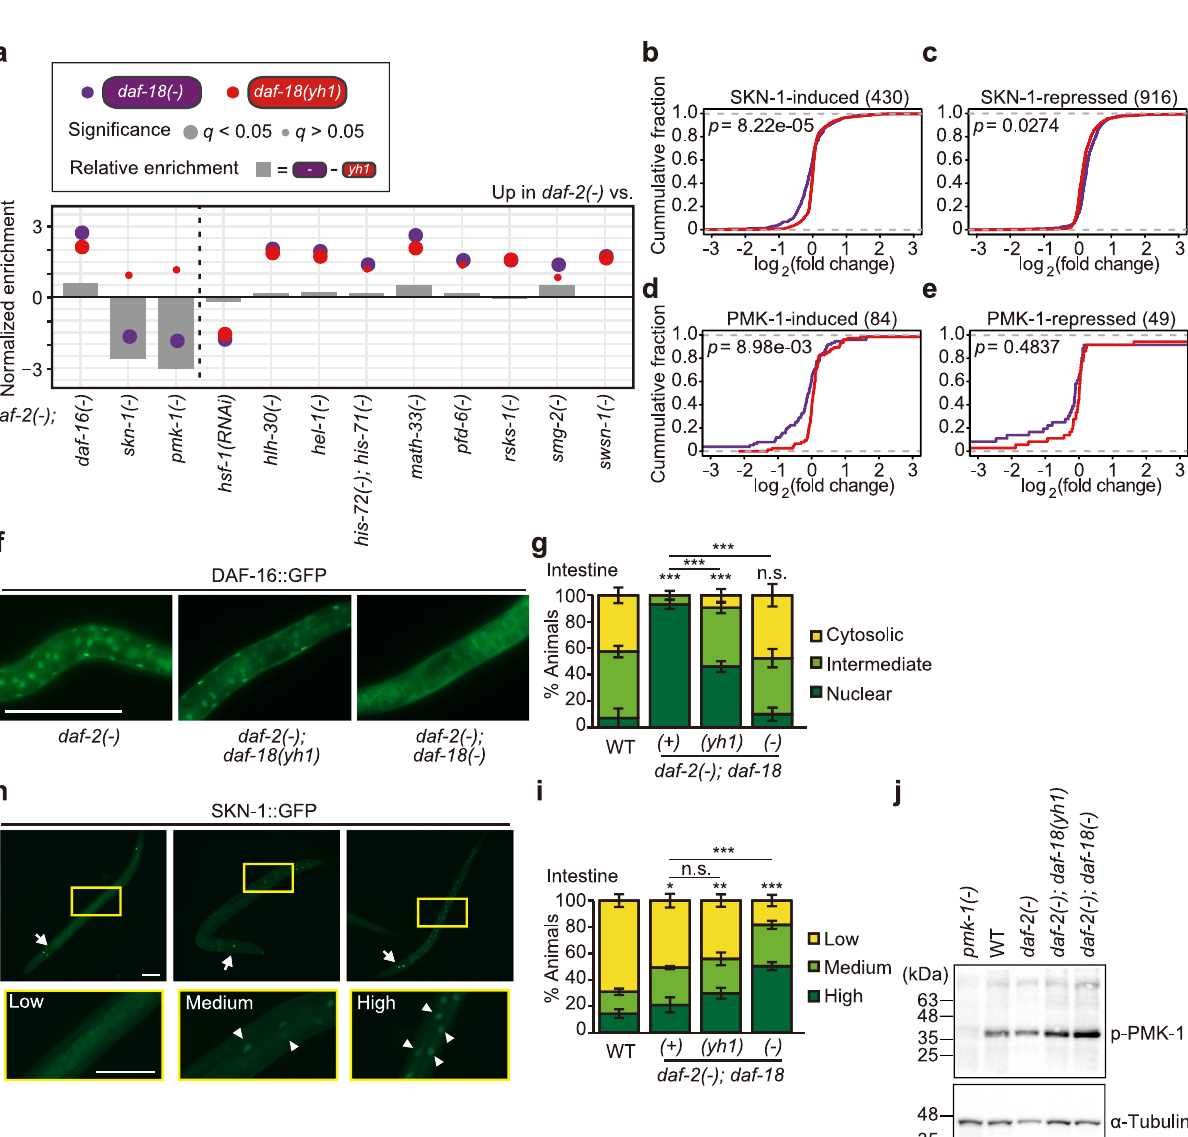
(Fig. 5a, b and Supplementary Fig. 9a, b, e, g, i). We also obtained similar results for target genes upregulated by PMK-1/p38 MAP kinase (Fig. 5a, d), which acts upstream of the SKN-1/NRF2 transcription factor 18,45 (See Fig. 5c, e for the effects of daf-18( − ) and daf-18(yh1) on the expression of SKN-1/NRF2- and PMK-1/ p38 MAP kinase-repressed genes in the daf-2( − )